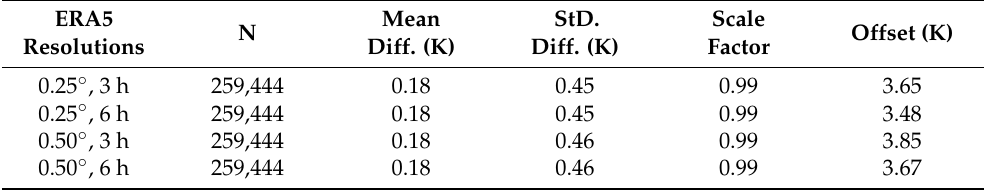
Table 2. Statistical parameters of the differences in SST skin derived from the Sentinel-3A SLSTR